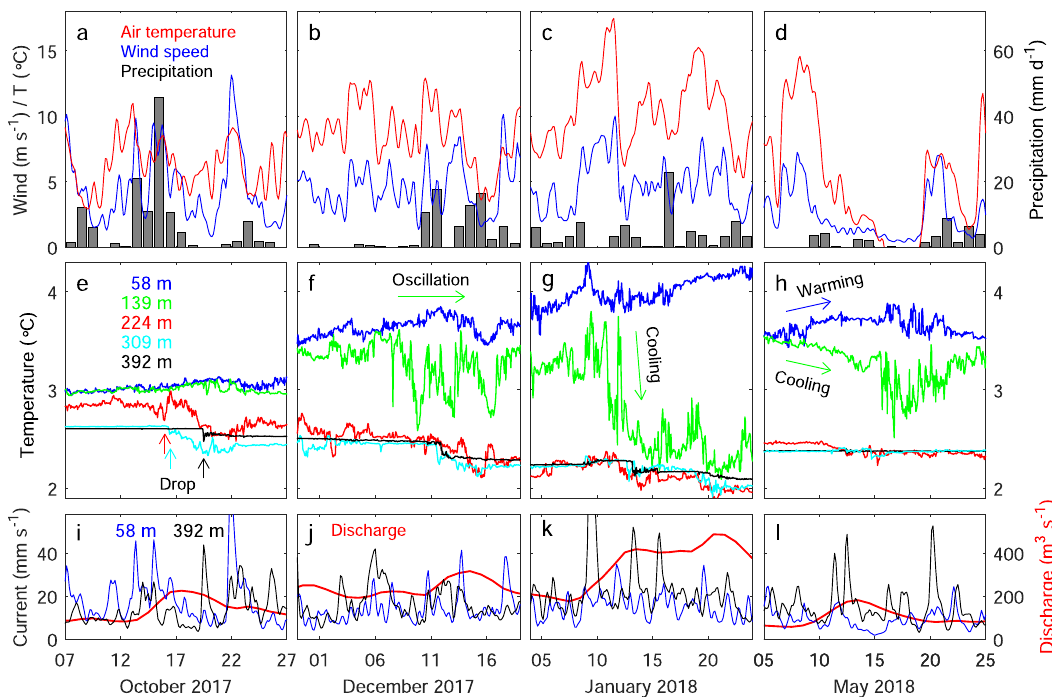
Fig. 6 Observations for the periods highlighted in Fig. 3. a – d Air temperature (red), wind speed (blue), and daily liquid precipitation (black). Temperature and wind speed were fi ltered with a 3-h window. e – h Water temperature at depths of 58 (blue), 139 (green), 224 (red), 309 (cyan), and 392 m (black). i – l Current speeds at the depths of 58 (blue) and 392 m (black) fi ltered with a 3-h window, and the discharge of Río Grey